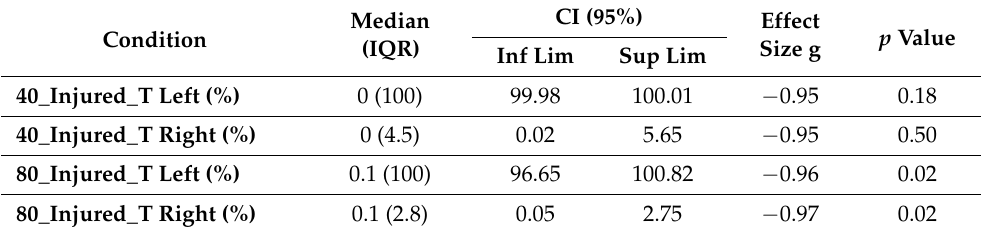
Table A2. Cont. Descriptive Data and Patellar Tendon Structure Changes (Last Day Pre-Season Training)